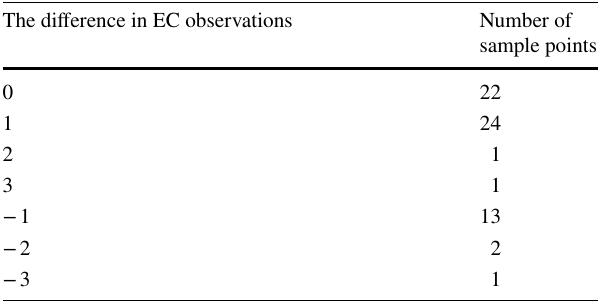
Fig. 13 EC observations by two methods Table 6 Analysis of EC observations The difference in EC observations